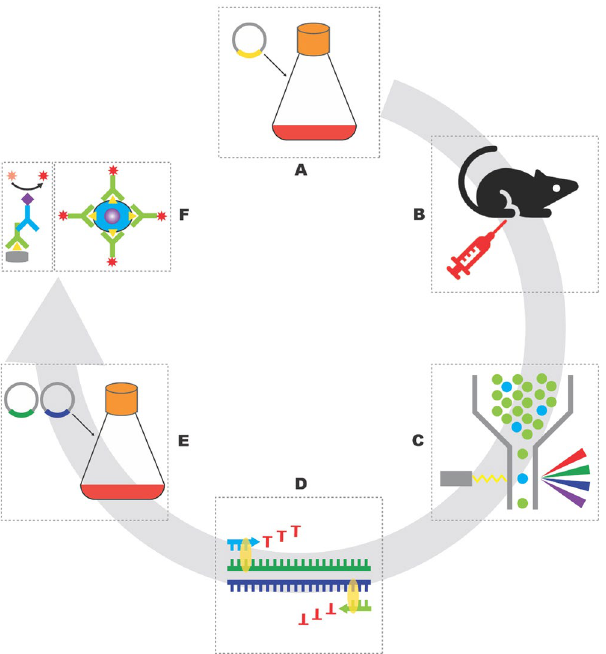
Figure 2. Flow chart to develop mouse anti-ferret CXCR5 and PD-1 monoclonal antibodies. Antigens were expressed by transiently transfection of Expi293 cells ( a ), C57BL/6 mice were intramuscularly immunized with purified antigens ( b ), antigen-specific B cells were single-cell-sorted by Aria III ( c ), the sequences of heavy and light chain variable domains of BCR were recovered by single cell PCR ( d ), candidate antibody clones were expressed by transiently transfection of Expi293 cells with heavy and light chain plasmids ( e ), purified antibodies were validated by ELISA and FACS ( f ). Illustration was drawn using Adobe Illustrator